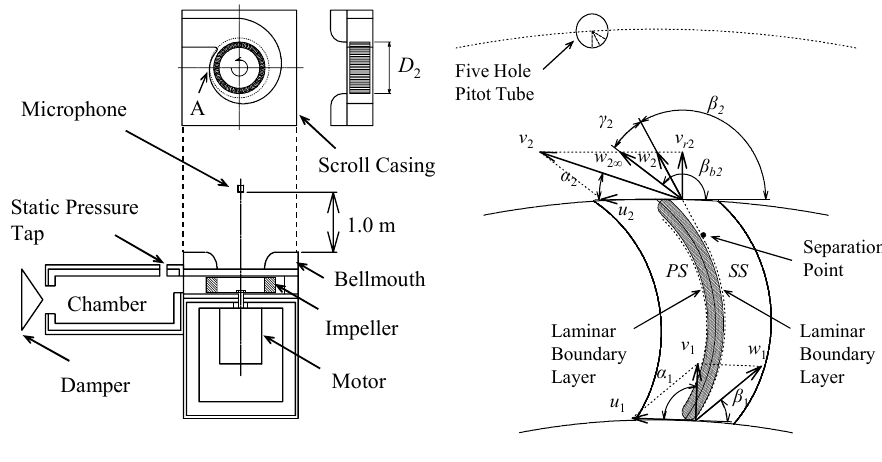
Fig.5 Experimental apparatus on the fan Fig.6 Velocity